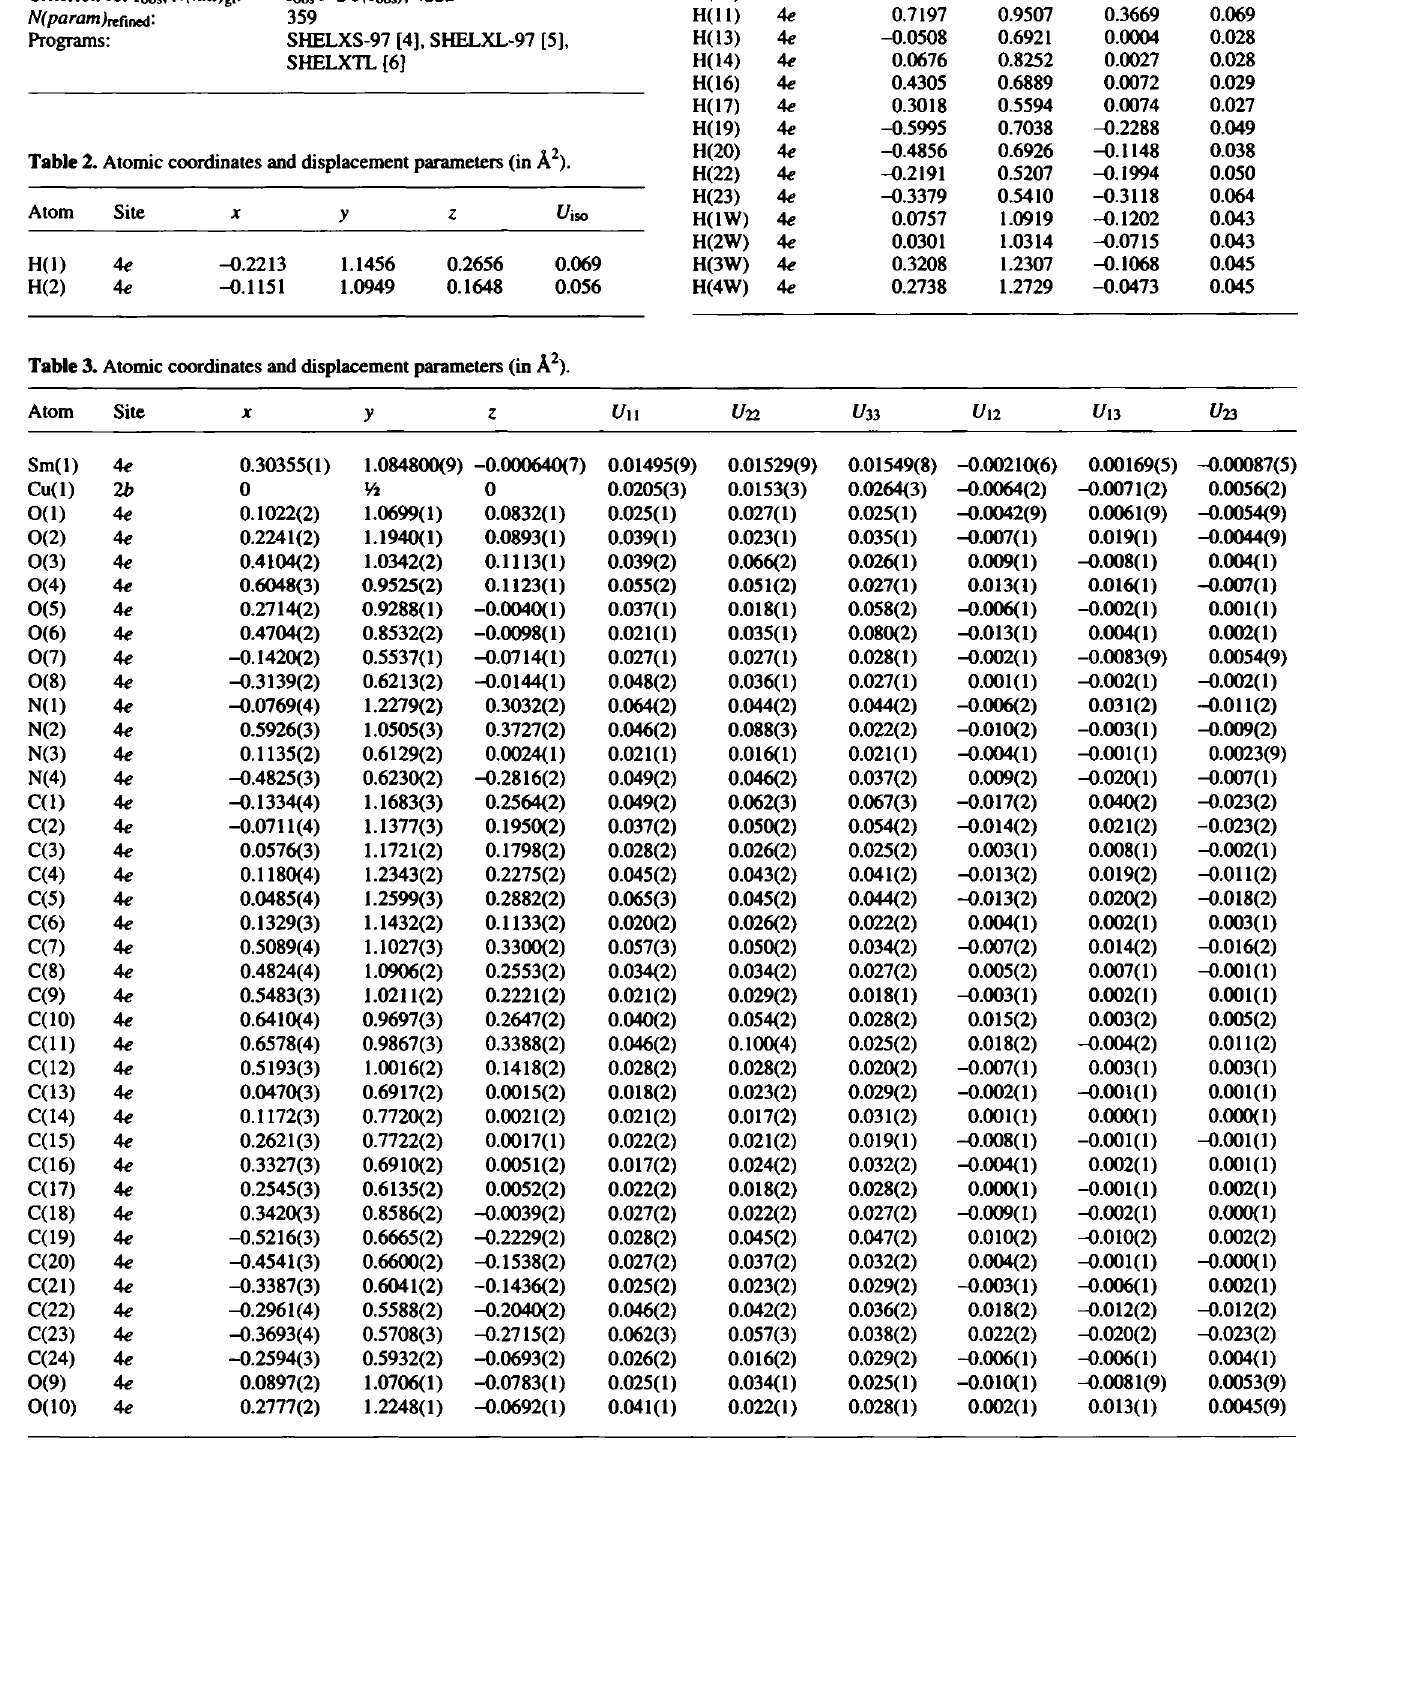
Table 2. Atomic coordinates and displacement parameters (in Â 2 ).